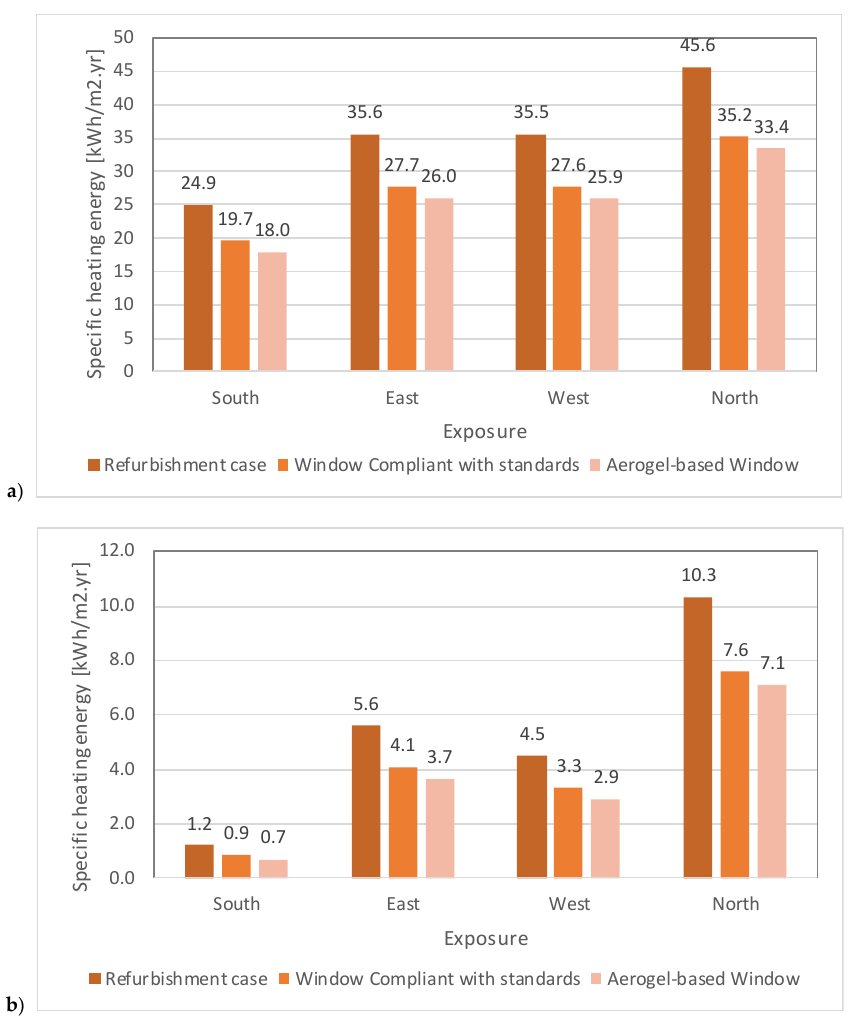
Figure 6. Energy use (kWh / m 2 · yr) in Toronto ( a ) and in Bari ( b ), according to exposures and window type.